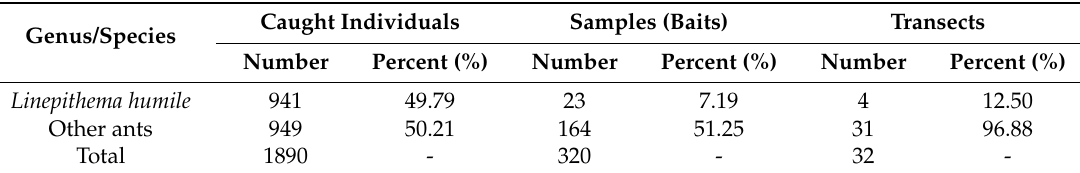
Table 2. Number of ants sampled using bait transects in the Cafayate area in 2014. Total number of individual, baits, and transects